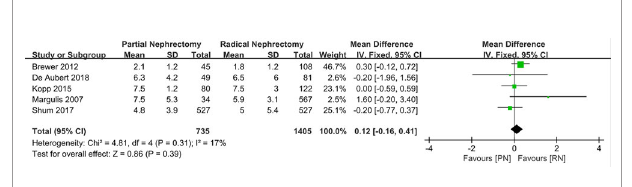
FIGURE 6 | Postoperative eGFR.